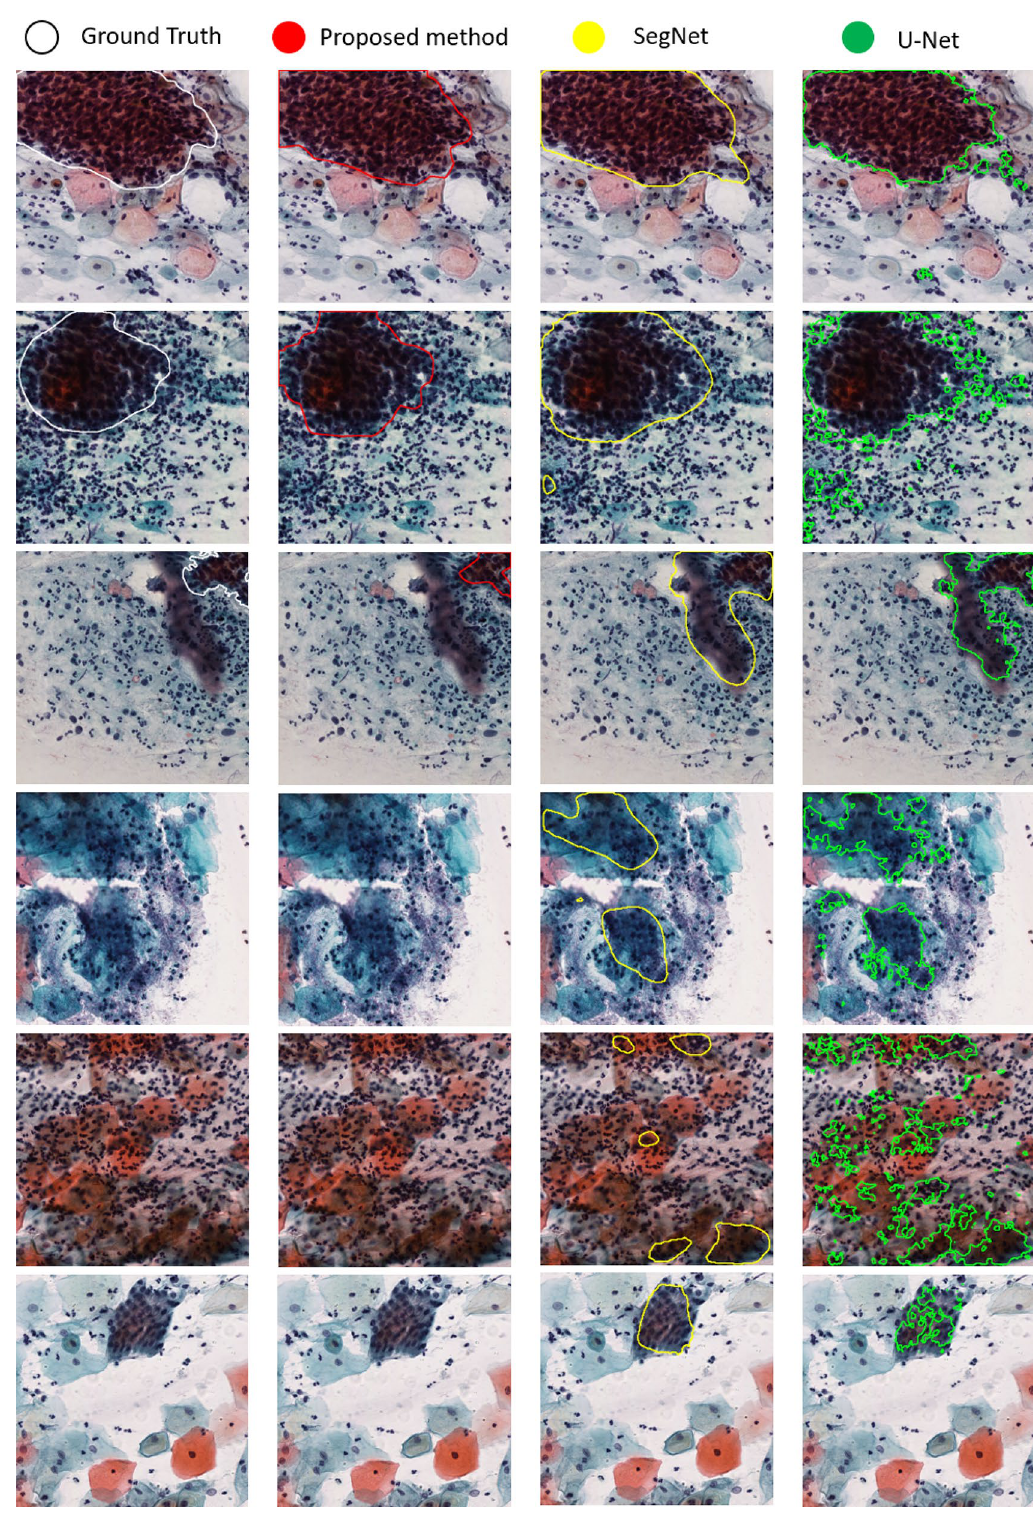
Figure 3. Qualitative segmentation results by the proposed method and two benchmark approaches for HSIL